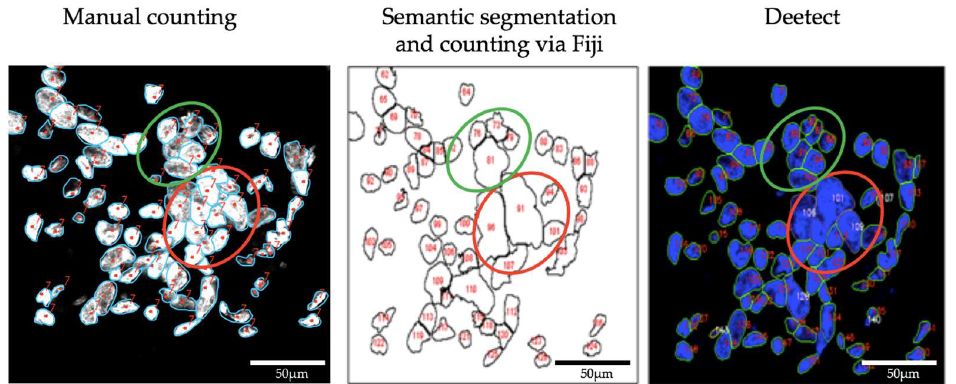
Figure 8. Comparison of application of the three methods to a sample region on a 2-z-substack. Regions with clustered nuclei that can still be visually distinguished (green circle, left panel) are not completely resolved by the semantic segmentation approach with Fiji (green circle, center panel) but are resolved by Deetect (green circle, right panel). In areas where it is difficult to distinguish nuclei borders visually (red circles) Deetect senses cell conglomerates (gray outlining, right panel) and estimates the number of cells present through the post-processing rules.